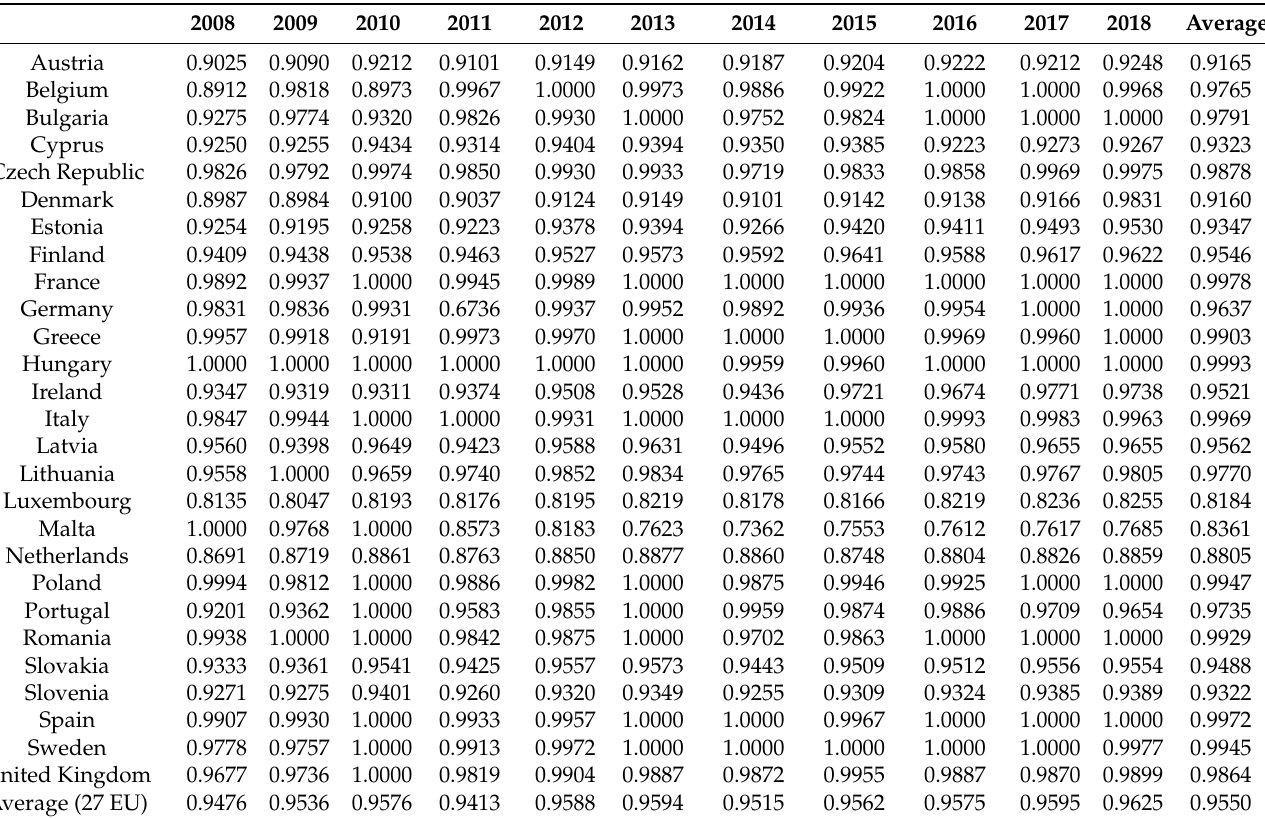
Table 3. Scores of technical eco-efficiency estimation in EU-27 under DEA-variable returns to scale (VRS): 2008–2018